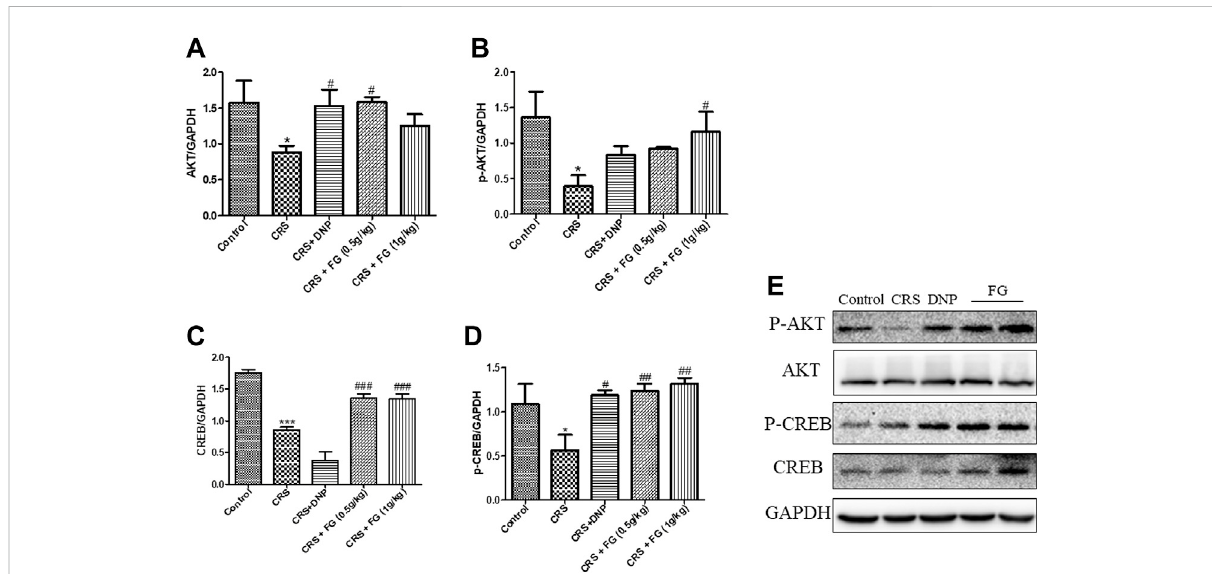
FIGURE 9 Effects of CRS, FG, and DNP on the AKT/CREB pathway expressed in the hippocampus of CRS-treated mice. (A – E) Expression levels of the protein were measured by western blot analysis and their respective histogram. n = 3 mice/group. Values represent the mean ± S.E.M. * p < 0.05, *** p < 0.01 compared with the control group; # p < 0.05, ## p < 0.01, ### p < 0.001 compared with the CRS group.